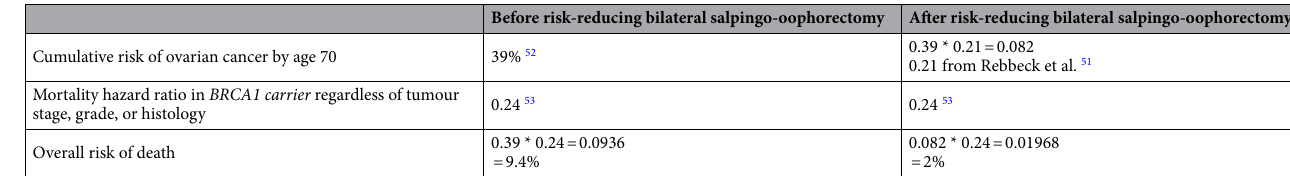
Before risk-reducing bilateral salpingo-oophorectomy After risk-reducing bilateral salpingo-oophorectomy